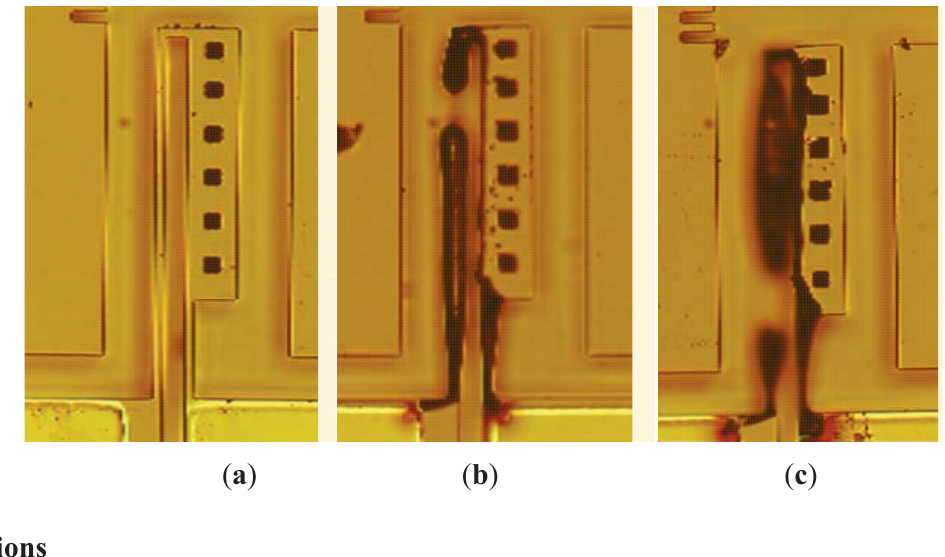
Figure 9. Thermal failure experiments: ( a ) SOI folded beam; ( b ) failure on hot arm due to melting at (~14.4 V); ( c ) multi failures in hot and flexure arms due to (~20